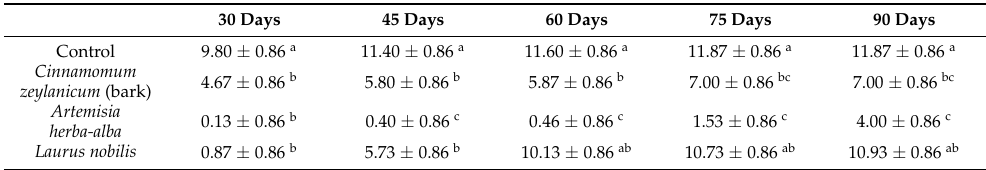
Figure 2. Number of sprouts per tuber over time of potatoes treated with distilled water (control), A. herba-alba , C. zeylanicum (bark), L. nobilis , and S. aromaticum EOs. Error bars represent the 95% confidence level of the means ( emmeans method ). Table 6. Number of germinated eyes of potato tubers treated with the most effective essential oils and the control at different time